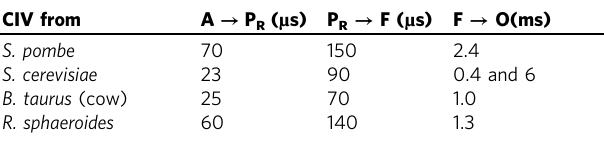
Timeconstants of reaction steps after oxygen binding (which was not resolved) tofully reduced S. pombe CIV, compared to the equivalent time constant obtained with S. cerevisiae 64 , bovine 63 and R. sphaeroides 63 CIV. The data with S. cerevisiae CIV display two components for the F → O reaction 64 ( n = 9, three independent preparations) (Fig. 6b, blue, 0.05 % instead of 0.01 % DDM was used in this measurement in order to keep the same detergent concentration as that used during puri fi cation and then investigate the effect of addition of GDN).